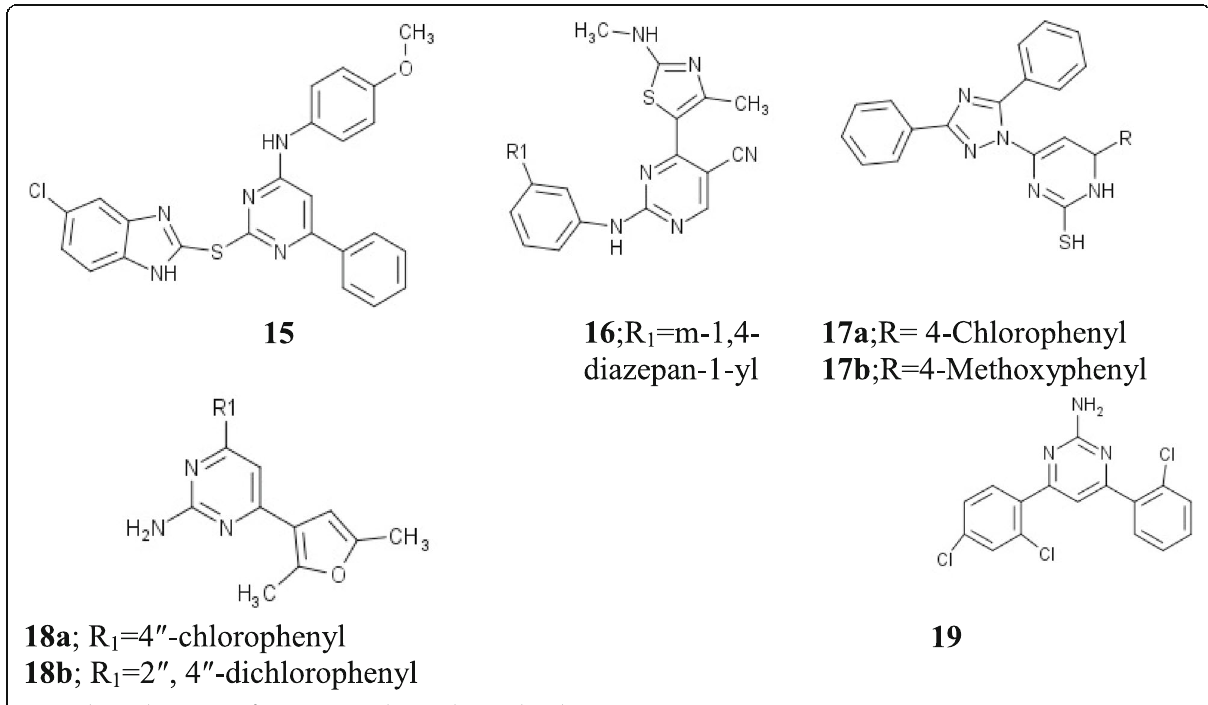
Fig. 6 Chemical structures of some 2,4,6-trisubstituted pyrimidine derivatives